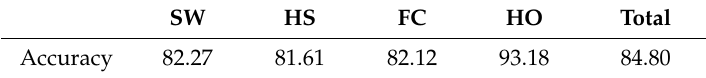
Table 4. Result of experimental validation set data [%].